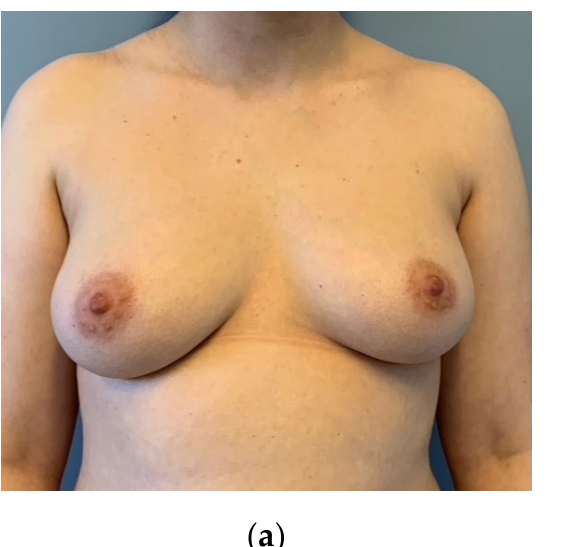
Figure 7. ( a ) Preoperative: 28-year-old patient with BRCA 1 mutation asking for risk-reducing mas- tectomy. Right side larger and more ptotic than left side. Sternal notch-to-nipple distance and nip- ple-to-IMF distance 2 cm longer than left side. ( b ) Three months after bilateral circumareolar mas- tectomy and reconstruction with bilateral DIEP-flaps and free NAC grafts. Flap weight was around 500 g on both sides. Mastectomy weight was 570 g on the right side and 500 g on the left side. The initial asymmetry was improved without additional scars.